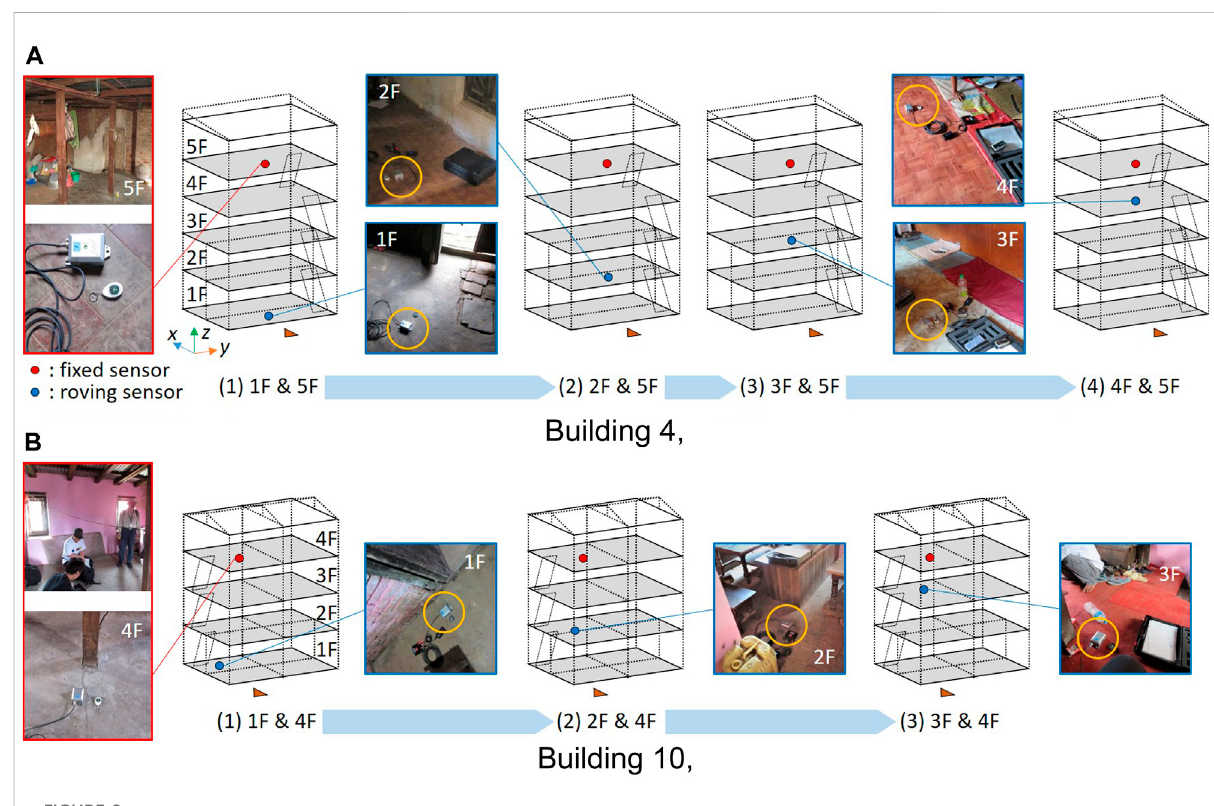
FIGURE 8 Location of the fi xed and roving sensors for the measurements on all fl oors. (A) Building 4, (B) Building